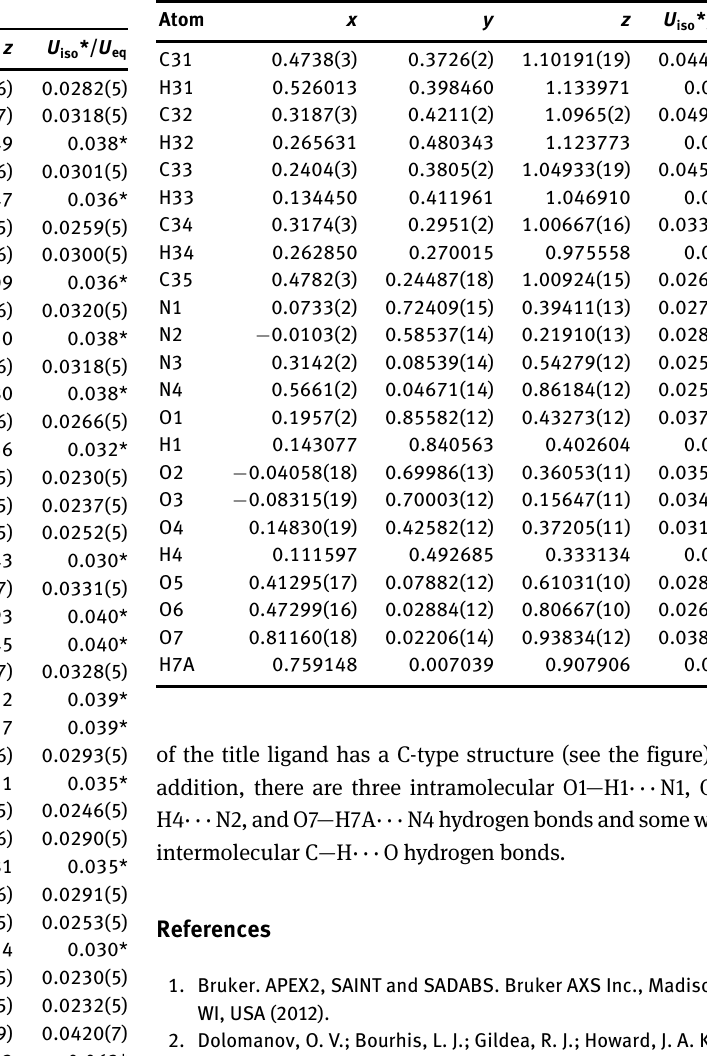
Table 2: Fractional atomic coordinates and isotropic or equivalent isotropic displacement parameters (Å 2